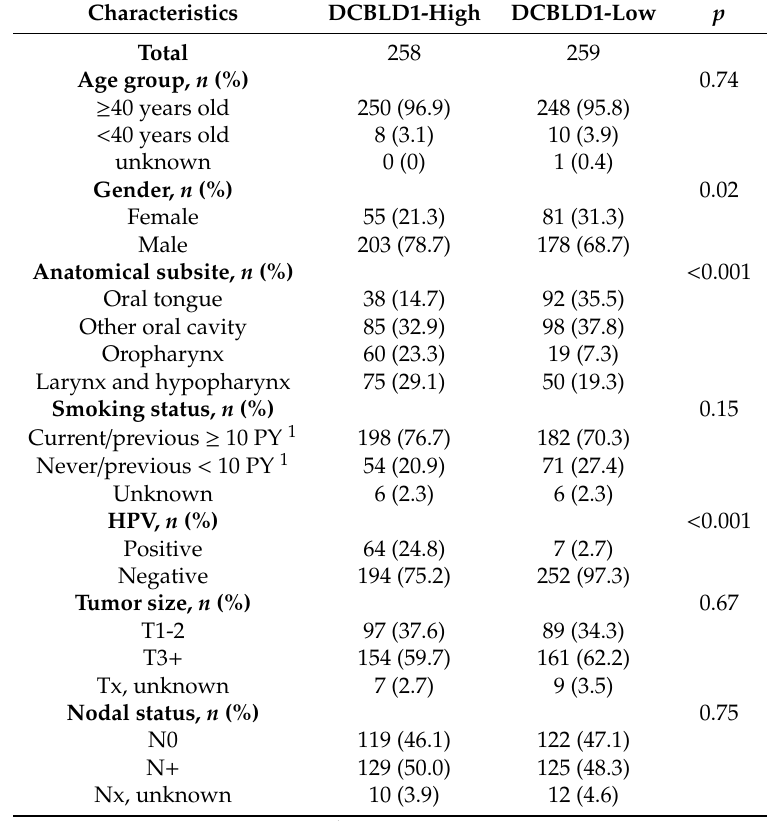
Table 2. Clinical features of the TCGA HNSCC cohort stratified by DCBLD1 gene expression. Characteristics